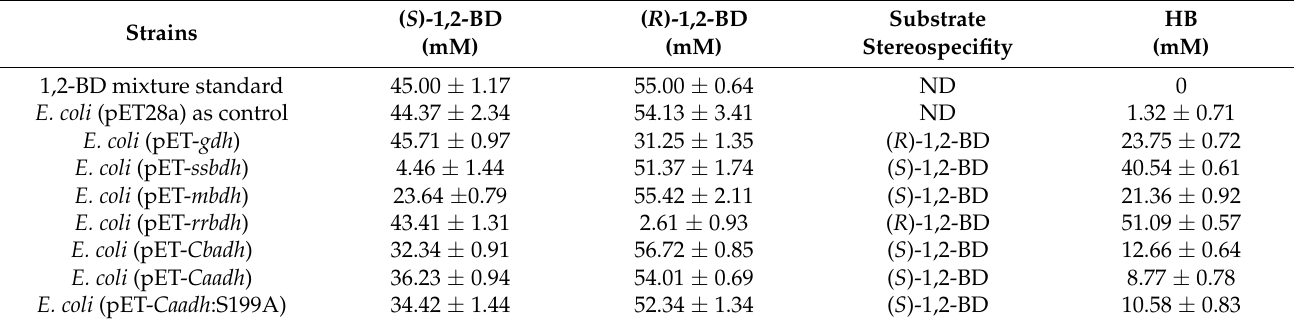
Table 2. Determination of substrate stereospecificity by seven candidate